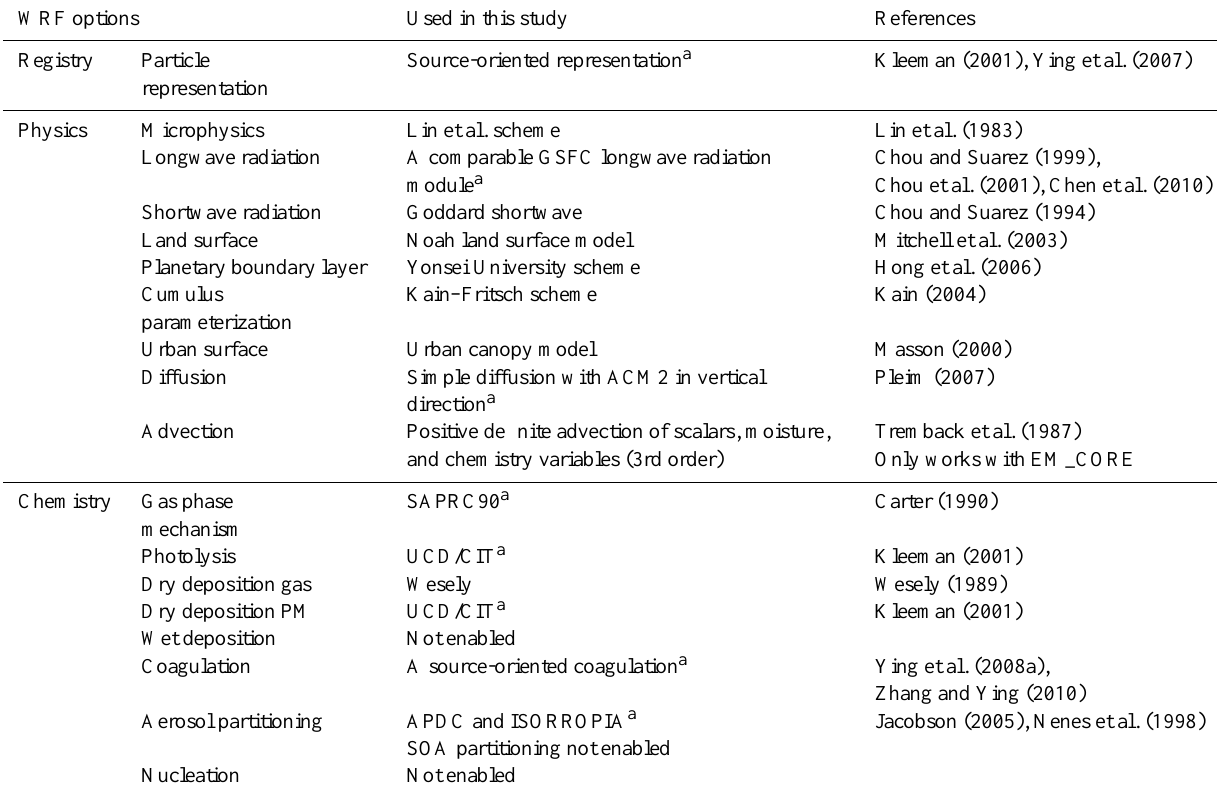
Table 1. Configuration options of the SOWC. a Option only tested with SOWC model (not regular